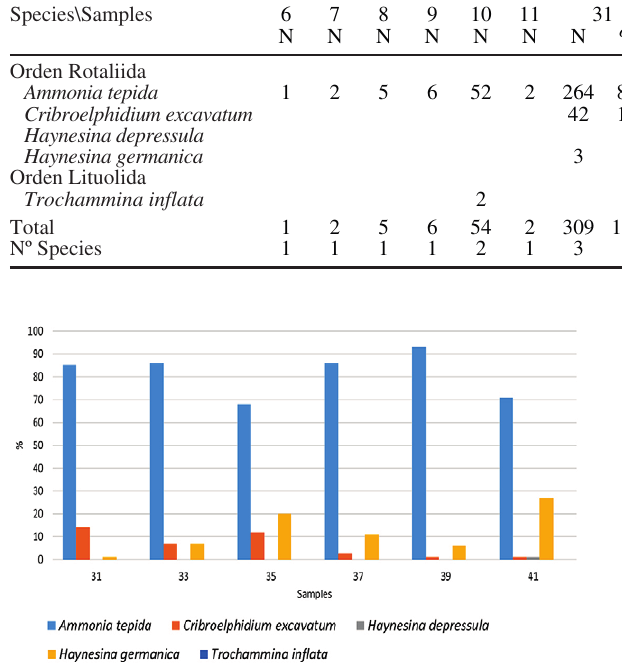
Fig. 4. – Benthic foraminiferal relative abundances from core